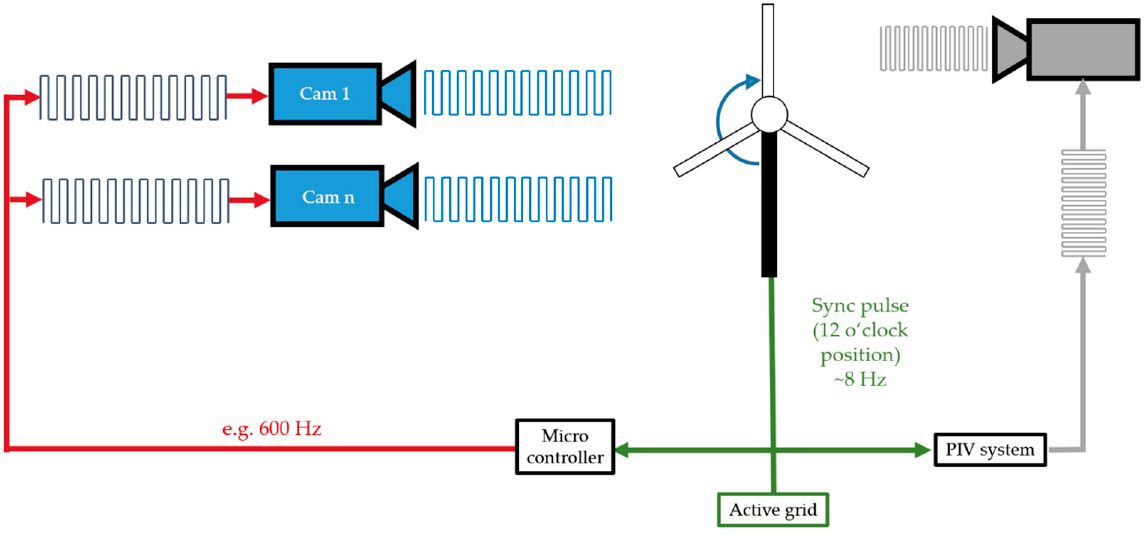
Figure 5. Scheme of synchronization of the experimental